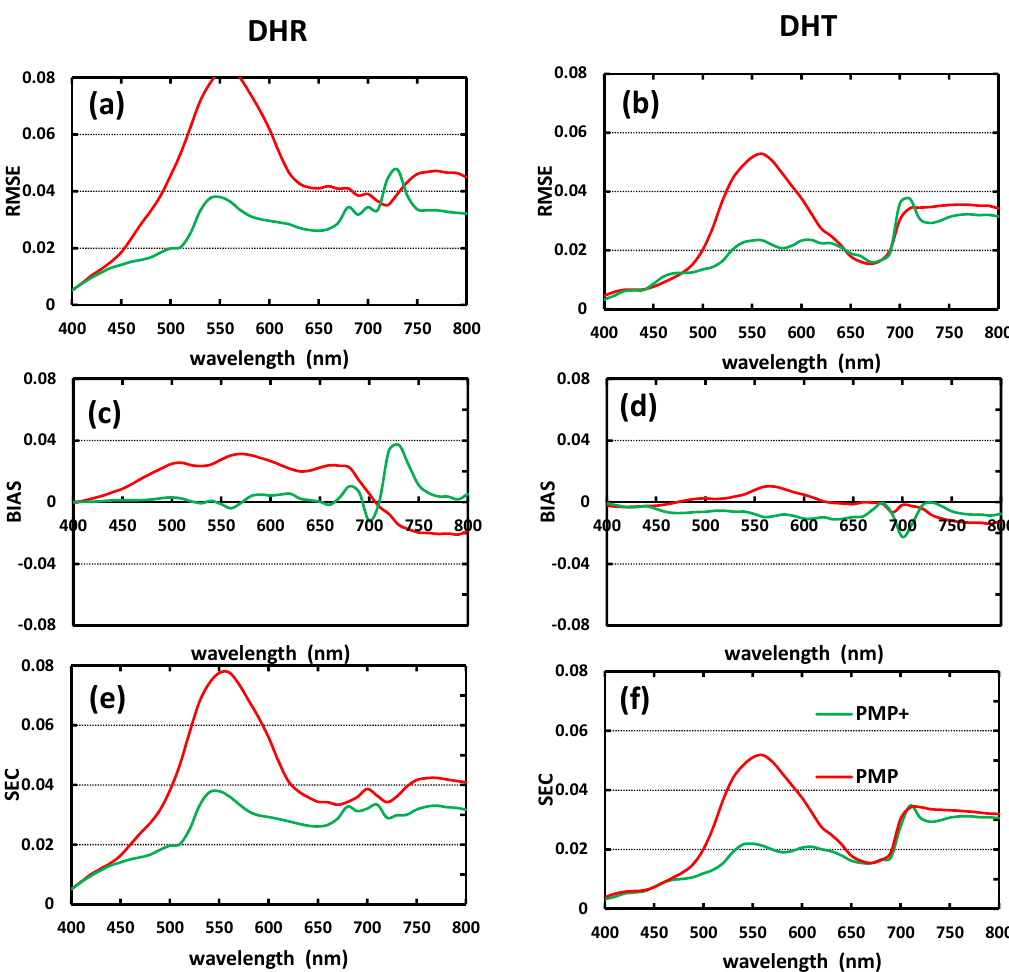
Figure 7. The valuation for simulated DHR (Directional Hemispherical Reflectance) and DHT (Directional Hemispherical Reflectance) spectra from PROSPECT-MP + (PMP + ) (black line, leaf sample number n = 28) and PSROPCT-MP (PMP) (grey line, n = 28): ( a , b ) for RMSE, ( c , d ) for BIAS, and ( e , f ) for SEC. The metrics RMSE, BIAS and SEC are Root Mean Square Error, Bias and Standard Error Corrected for the errors between the measured and modeling spectra, respectively.